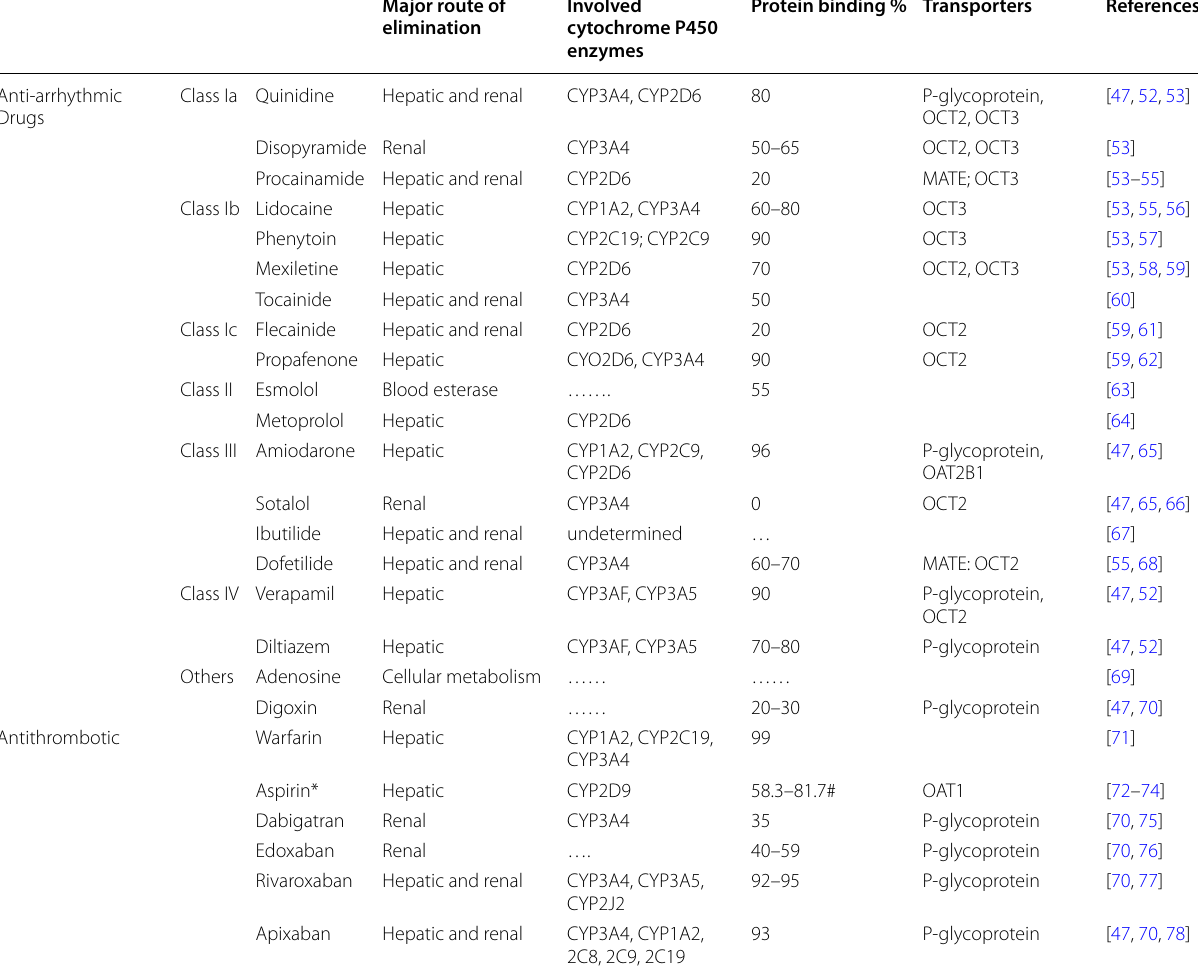
Table 1 Pharmacokinetic properties of some anti-arrhythmic and antithrombotic drugs commonly used in management of cardiac